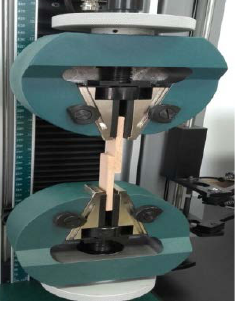
( e ) Figure 4. SEM images of ( a ) nanocomposite in powder form, ( b ) crack surface, ( c ) 0.1 wt.% COOH- MWCNT, ( d ) 0.5 wt.% COOH-MWCNT, and ( e ) 1.0 wt.% COOH-MWCNT in PMMA.